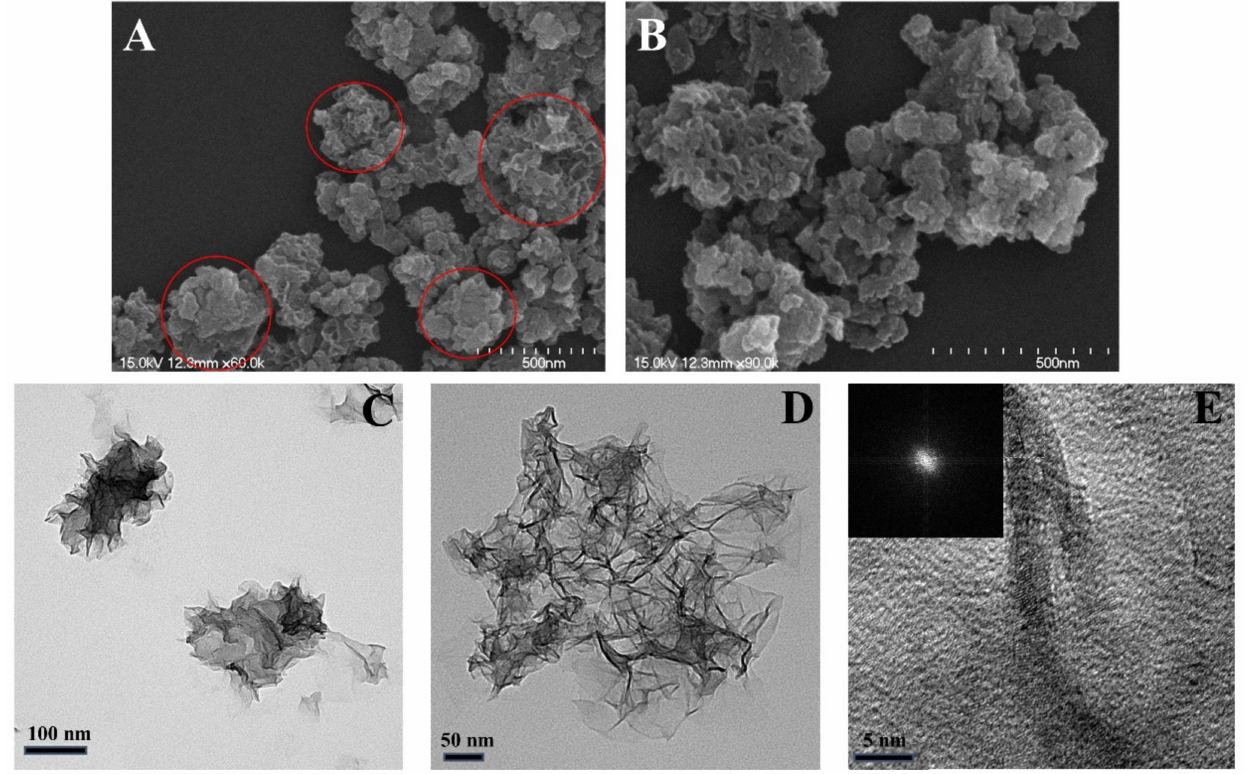
Figure 3. ( A , B ) SEM images; ( C , D ) TEM images; and ( E ) HRTEM image (inset: fast Fourier transform (FFT) pattern) of the NPCD-MnO 2 nanocoral